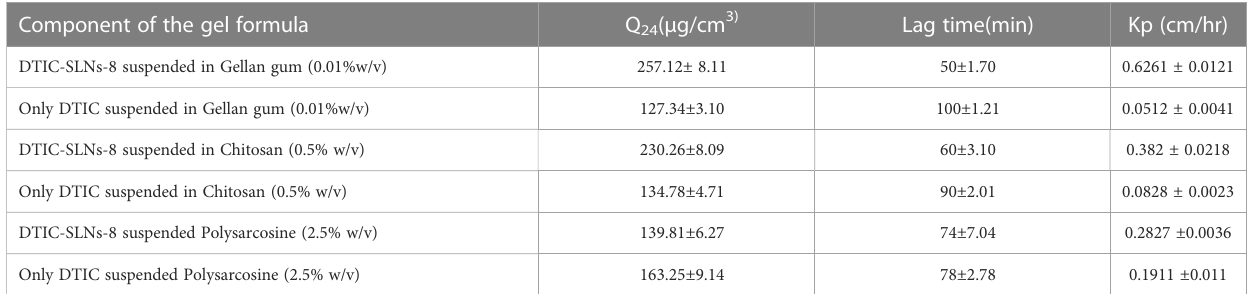
TABLE 4 The permeation parameters of both DTIC-SLNs-8 and free DTIC in various gel bases [Gellan gum (0.01%w/v), Chitosan (0.5% w/v), Polysarcosine (2.5% w/v)] to illustrate the increase in drug permeation when loaded into SLNs and the impact of different gel bases on both the SLNs and the free drug permeation (means± SD, n=3).